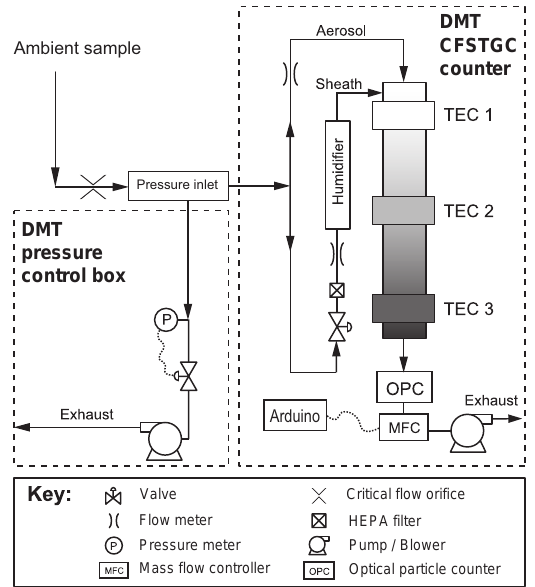
Figure A1. Instrument setup for measuring CCN spectra during